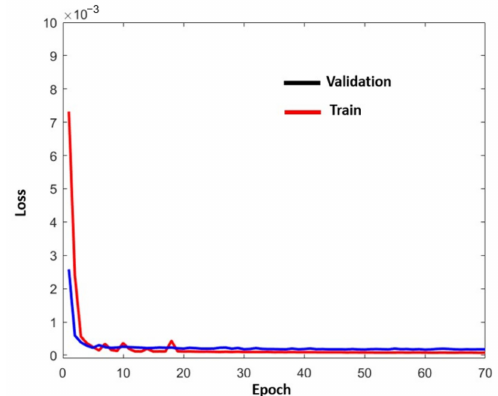
Figure 13. Evaluation curve for the Z coordinate using real landing